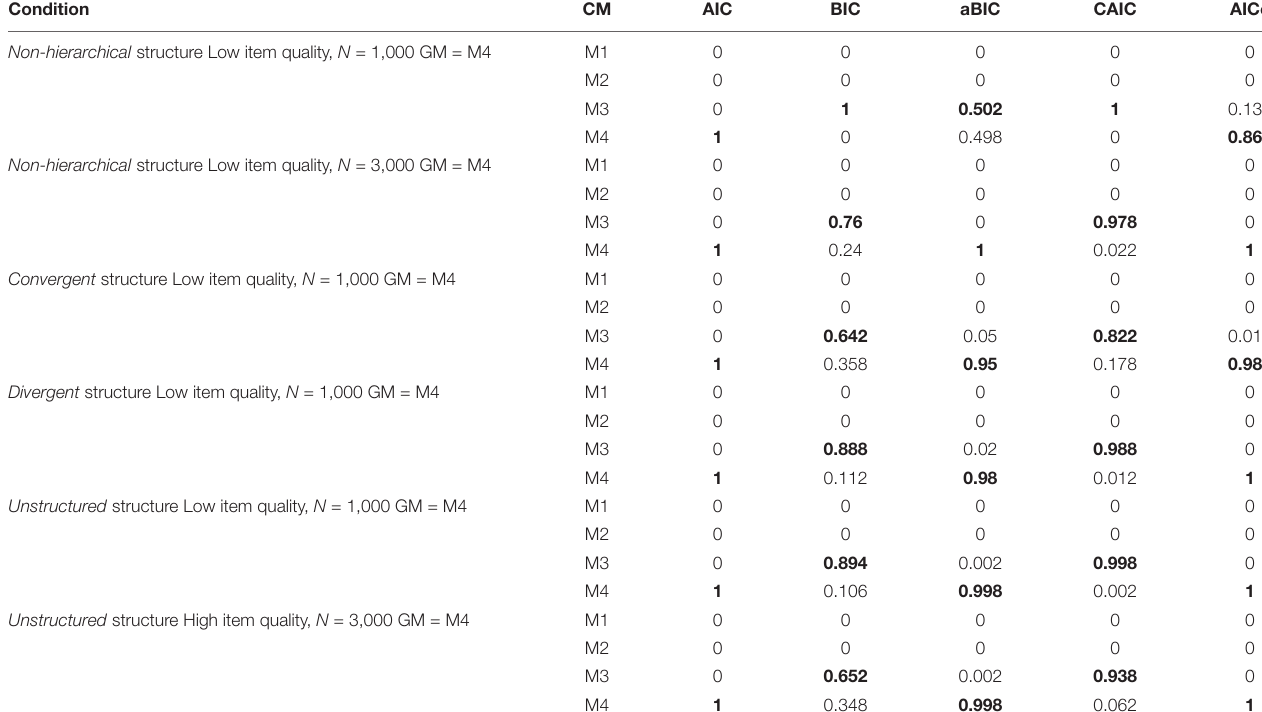
TABLE 8 | Selected results of CDRs of RFIs for different models. Condition CM AIC BIC aBIC CAIC AICc M1